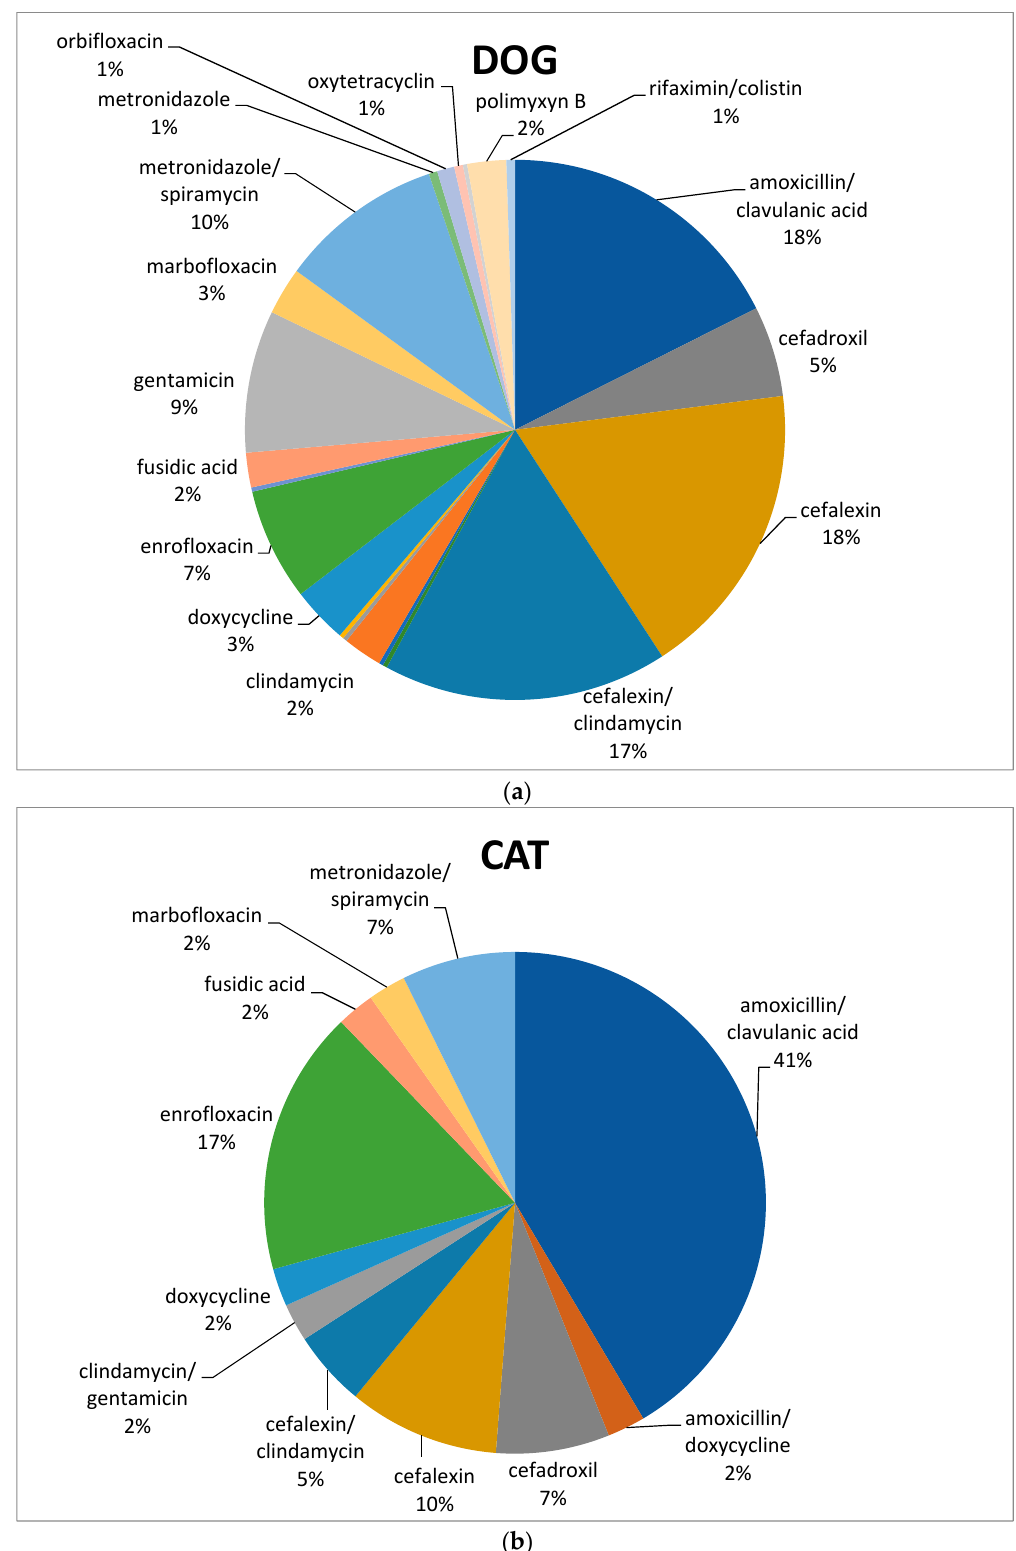
Figure 3. Percentage of selected antimicrobials prescribed in dogs ( a ) and cats ( b ) after the mandatory use of VEP. As far as clinical conditions were concerned, antimicrobials were prescribed to treat infections affecting the skin, eye, ear, oral cavity, gastrointestinal tract, and genitourinary and respiratory tract diseases. The surgery section included neurosurgery and soft tissue